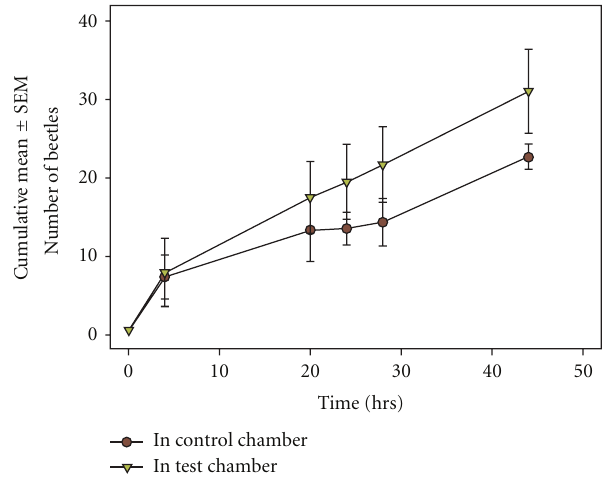
Figure 4: Cumulative mean ± SEM number of beetles moving into control or test (MeSA-treated) lateral chamber of arena over time.